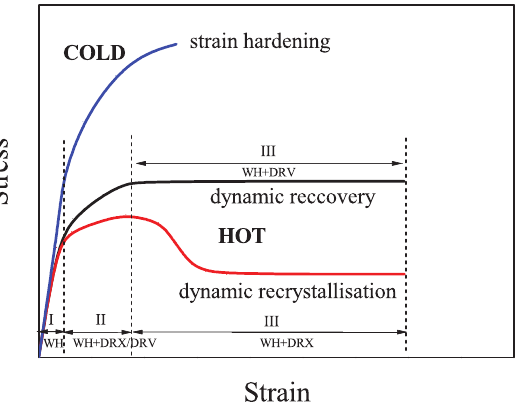
Fig. 2: Typical flow curves during cold and hot deformation